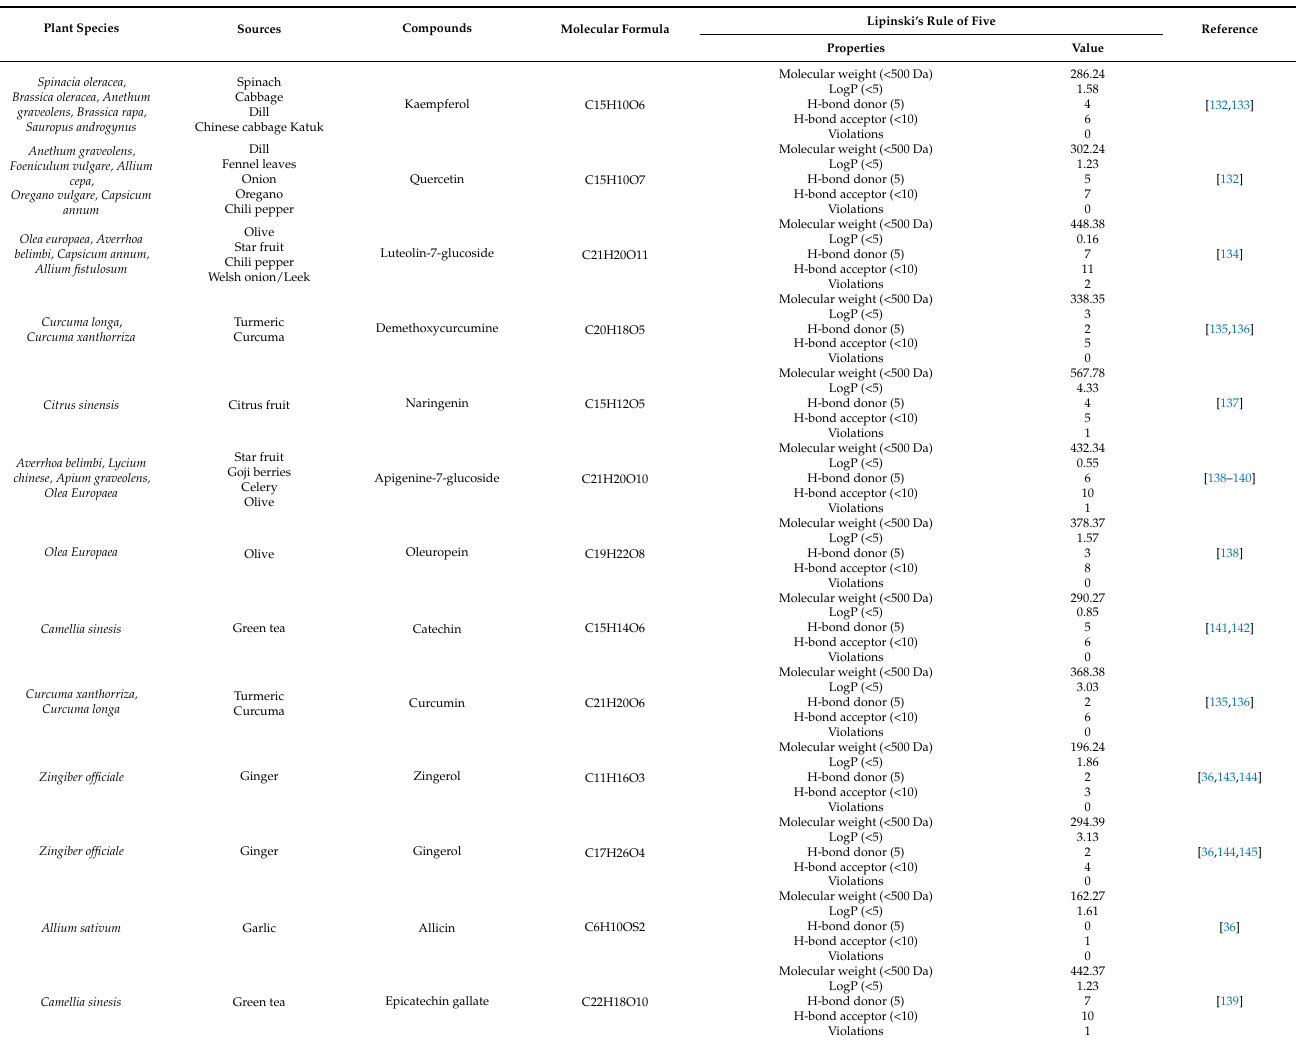
Table 2. Plant sources of polyphenolic compounds with anti-protease